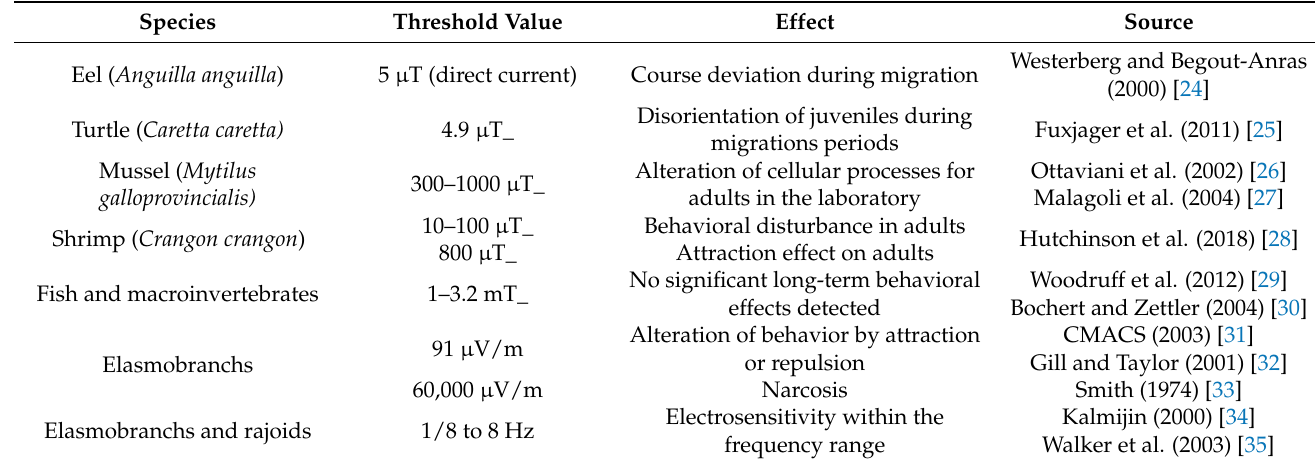
Table 6. Documented effects of EMF on marine